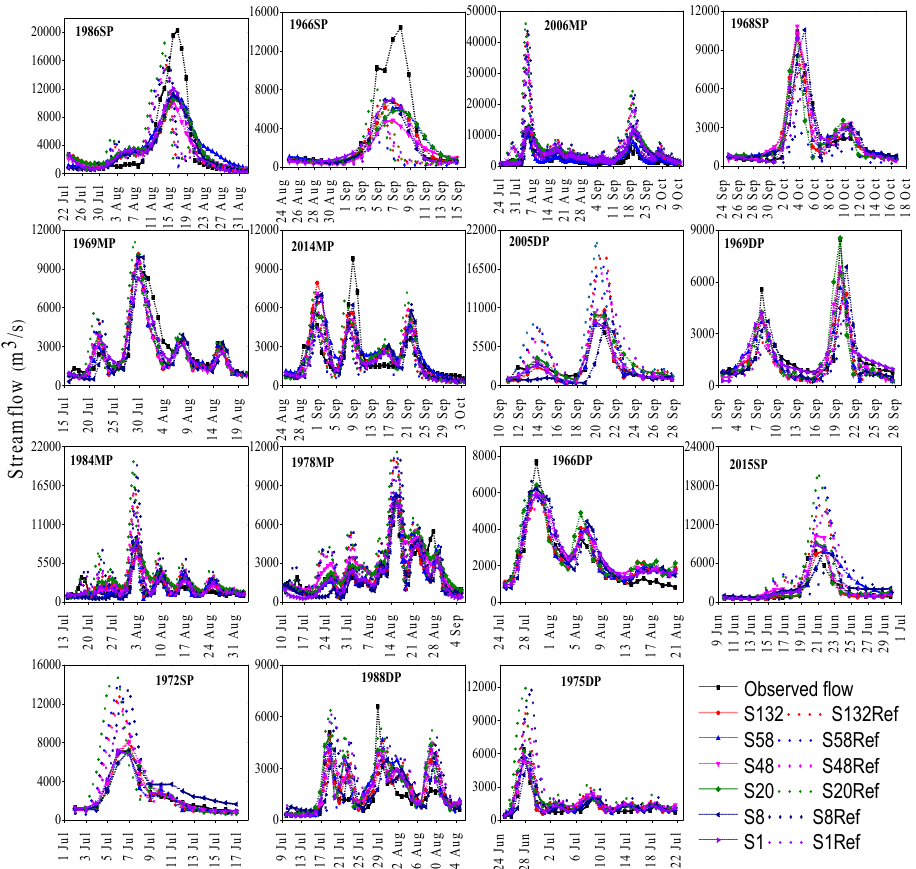
Figure 8. Comparison of hydrographs of observed and estimated streamflow of reference (denoted by Ref) and calibration scenarios for six configurations, for the 15 events at Konta. Hydrographs are arranged as per the magnitude of the peak flow of an event. The black line corresponds to observed flows, and other colors correspond to estimated flows from different spatial resolutions.